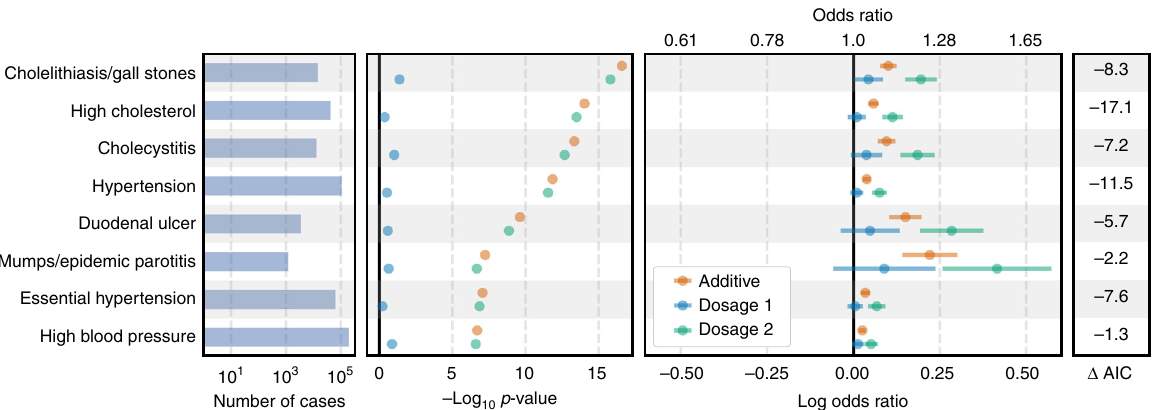
Fig. 4 Non-additive associations for FUT2. Association results under additive and non-additive logistic regression models for predicted FUT2 heterozygous or homozygous knockouts (KOs) with a difference between non-additive model AIC and additive model AIC < − 1. The left panel shows the number of cases per phenotype. The middle-left panel shows the -log 10 p value for the KO association analysis. The middle-right panel shows the estimated log odds ratios and 95% con fi dence intervals under an additive model (orange) and under a non-additive model for heterozygote KOs (blue) and homozygote KOs